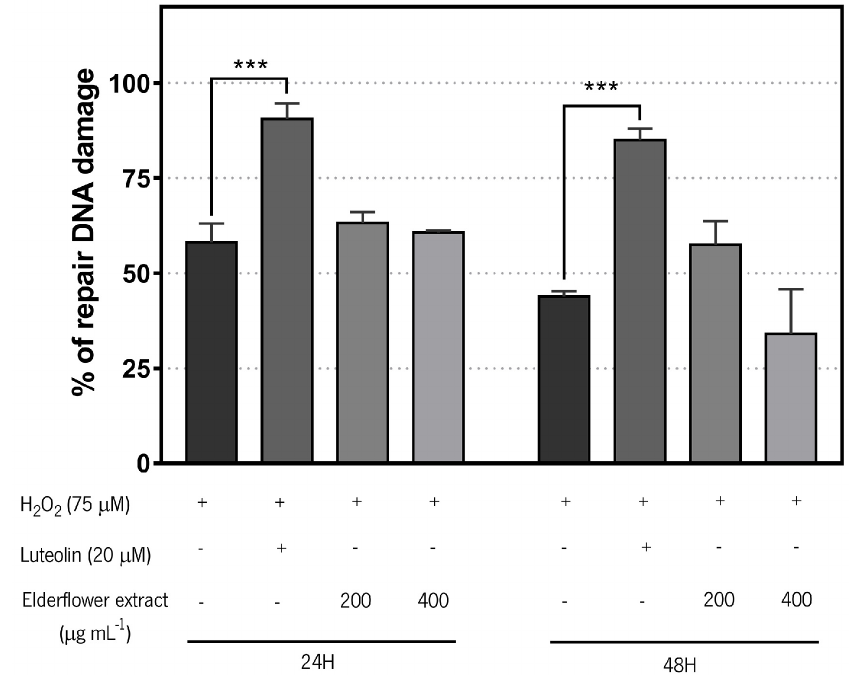
Figure 5. Extent of repair of 75 µ M H 2 O 2 -induced damage in RKO cells after pre-incubation during 24 and 48 h with S. nigra (elderflower) aqueous extract (200 and 400 µ g mL − 1 ) or luteolin (20 µ M) followed by 5 min of recovering time. [+]—compound present; [-]—compound absent. Results are expressed as mean ± SD, of at least three independent experiments. *** p < 0.001. Table 4. MBC and MFC performance of S. nigra flower aqueous extract against pathogenic organisms. Microbial